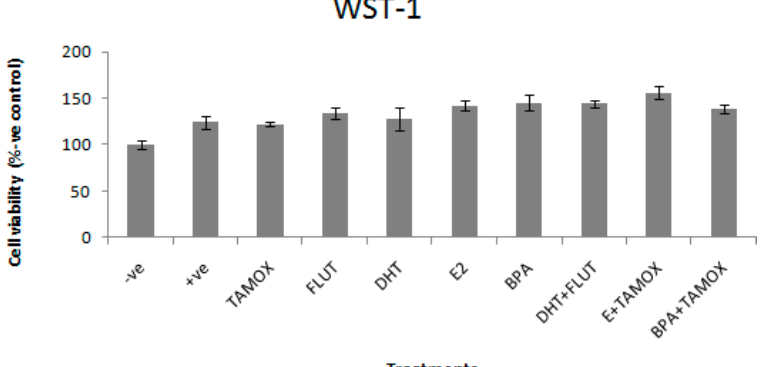
Figure 1. Effects of 5 α -dihydrotestosterone (DHT), Estradiol (E2), and Bisphenol A (BPA) alone and in combination with flutamide or tamoxifen on viability of RAW264.7 cells, stimulated with 1 μ g/mL lipopolysaccharide (LPS). The stimulated cells were treated with 5 μ g/mL of DHT, E2, or BPA; and flutamide (FLUT) or tamoxifen (TAMOX) at 2 μ g/mL; negative control was treated with normal medium and positive control was treated with LPS (1 μ g/mL). The results of cell viability are presented as percentage of negative control.